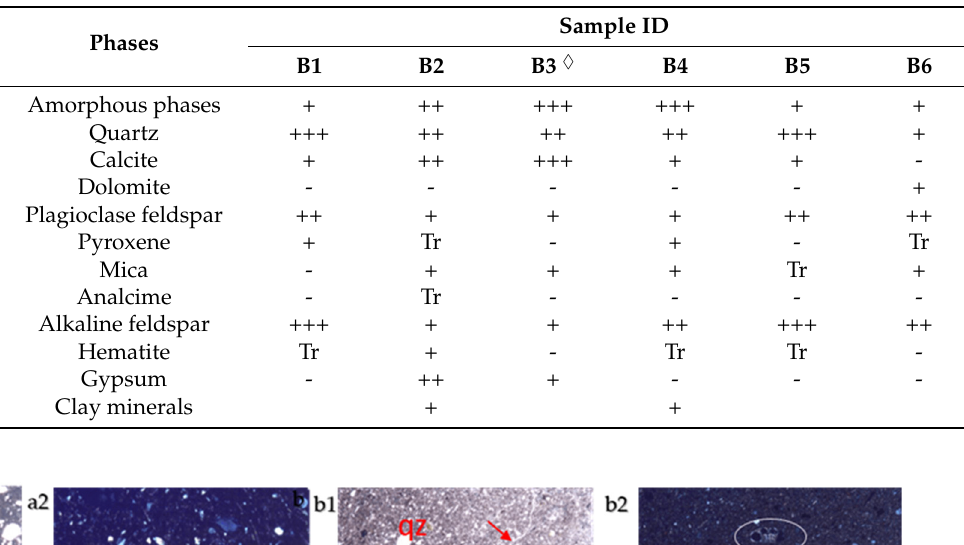
Table 2. Mineralogical phases in red and yellow bricks revealed by XRD semi quantitative analyses performed by the XPower12 program. +++ indicated phase abundance in the range 25–20%, ++